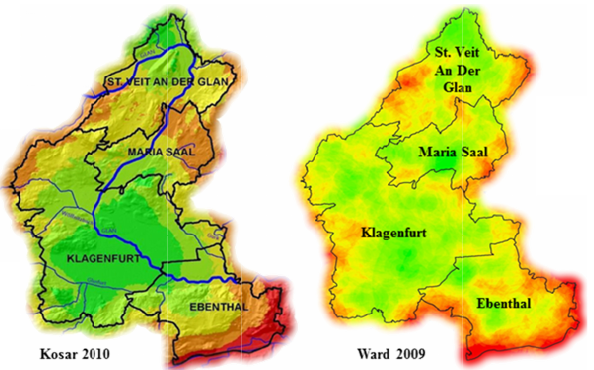
Fig. 3. 2010 Kosar SRI compared to 2009 Ward